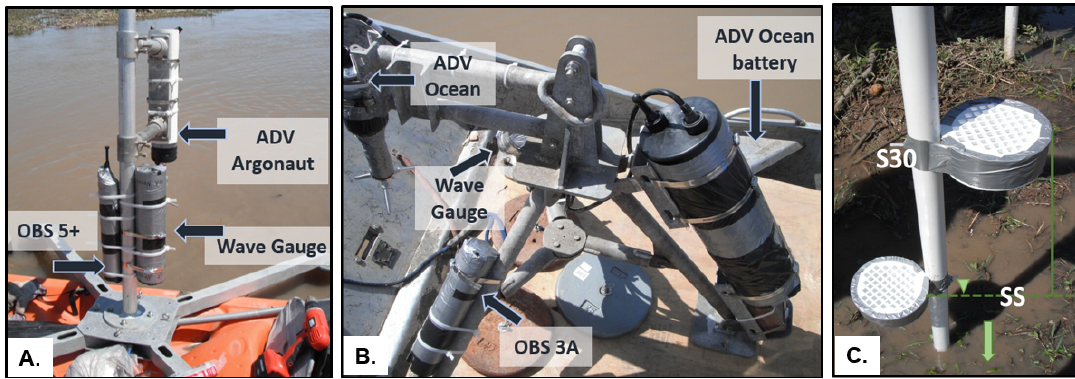
Figure 2. ( A ). X-shaped platform deployed at Mike1 with an acoustic Doppler velocimeter (ADV) Argonaut, optical backscatter sensor (OBS) 5+, and a wave gauge. ( B ) Tripod deployed at Mike3 with instruments including an ADV Ocean (sensor and external battery), OBS 3A, and a wave gauge. ( C ) Set of sediment traps used for the collection at the sediment surface (S-S) and 30 cm above the bed (S-30); the picture was taken before the set was inserted into the sediment.